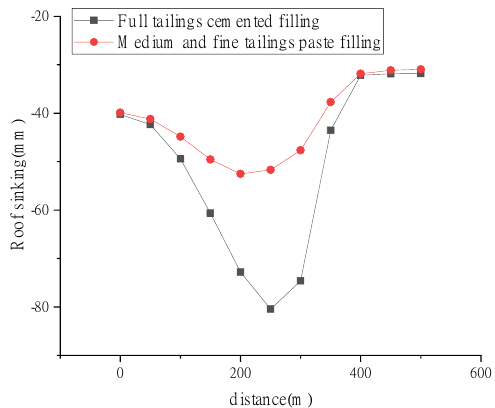
Figure 14. The roof subsidence curves of different backfilling bodies.